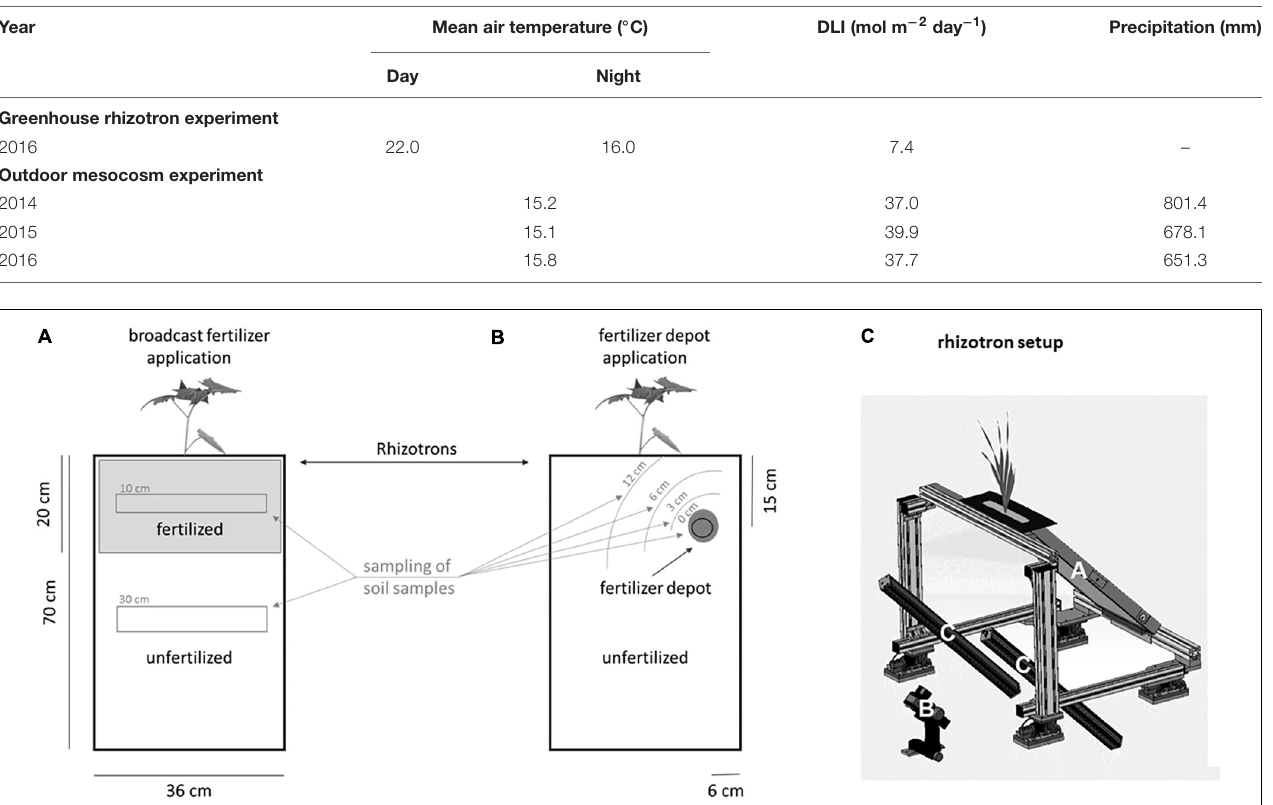
FIGURE 1 | Illustration of the fertilizer application as broadcast ( A : homogeneous digestate/NPK application) or depot ( B : localized digestate application) fertilization in rhizotrons and soil sampling schema. Control rhizotrons did not receive any fertilization and are therefore not included in the illustration. (C) Schematic drawing of the imaging station of the automated phenotyping platform, GrowScreen-Rhizo2 . The inclination angle of the rhizotron (A) is fixed to 45 ◦ with the transparent surface of the rhizotron facing downward. The image of the root system is taken by a high-resolution camera (B) , positioned at a distance of 1 m to the rhizotron surface. The positions and angles of the two light panels (C) are adjusted to allow homogeneous illumination and prevent reflections in the